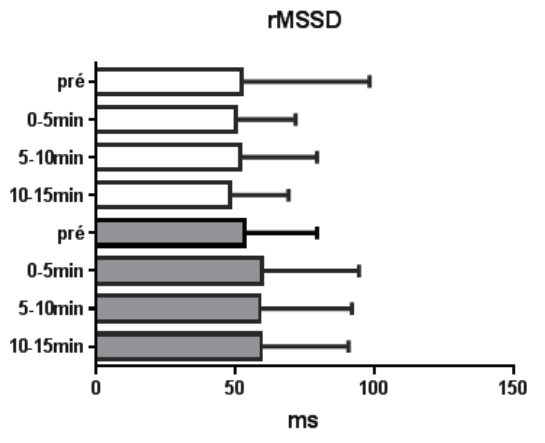
Figure 3 - rMSSD mean values, which represent the square root of the mean of the sum of the squared differences between